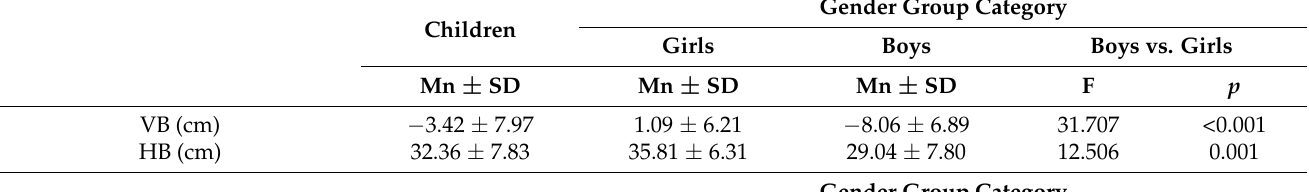
Table 1. Cont. Gender Group Category Children Girls Boys Boys vs.